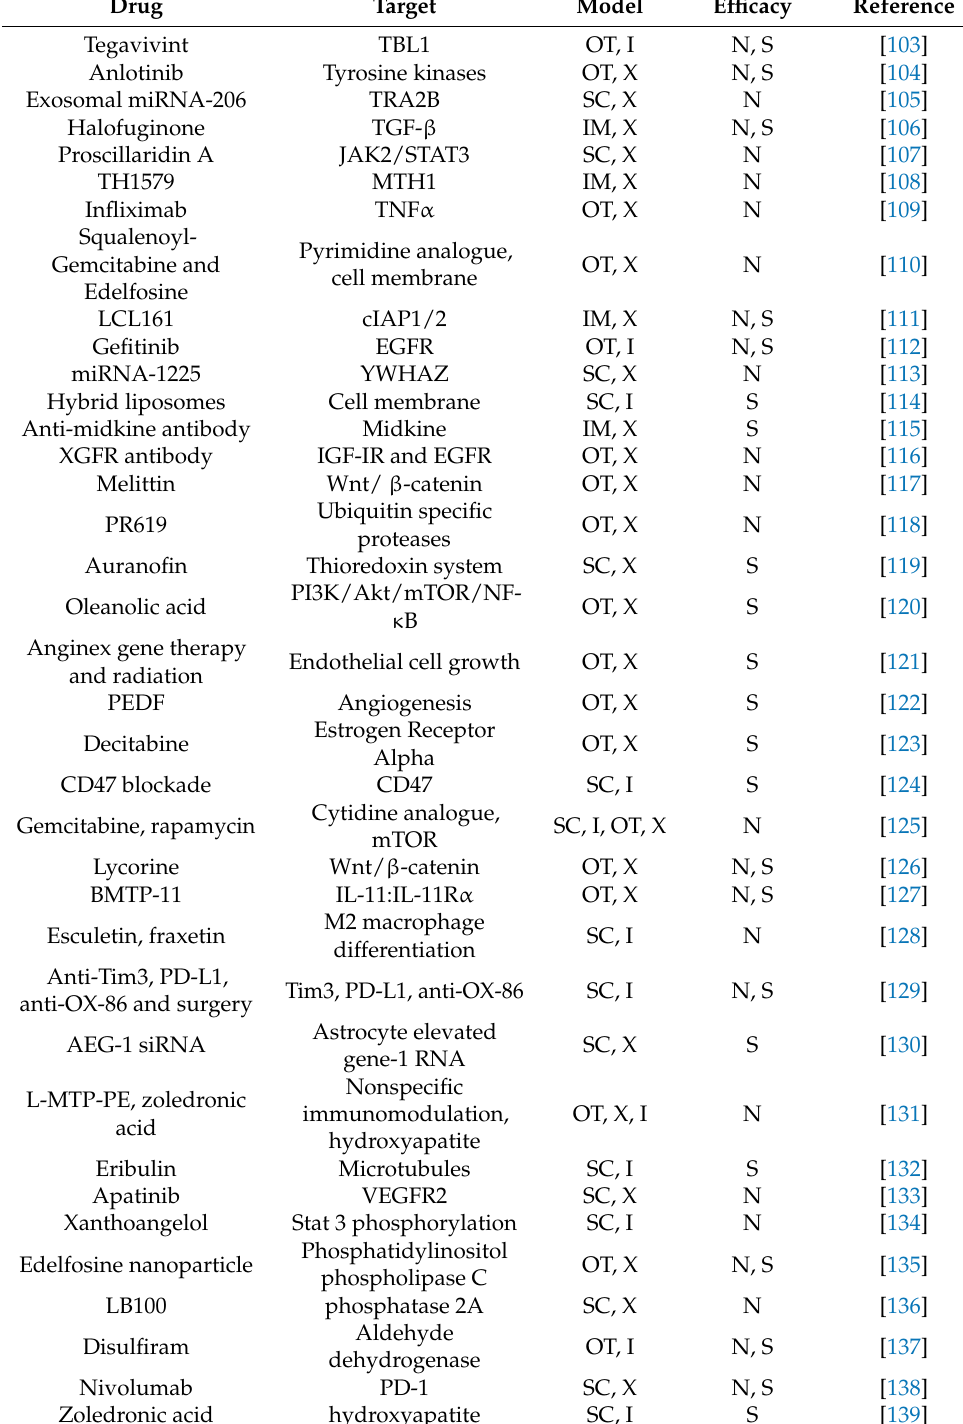
Table 2. Summary of studies reporting the efficacy of novel therapies (not yet evaluated in clinical tri- als) against metastatic osteosarcoma using pre-clinical models of mice bearing primary osteosarcomas. N, significantly reduced number of individual metastases compared to control mice; S, significantly reduced size of metastases compared to control mice; OT, orthotopic tumor; IM, intramuscular tumor; SC, subcutaneous tumor; I, isograft; X,